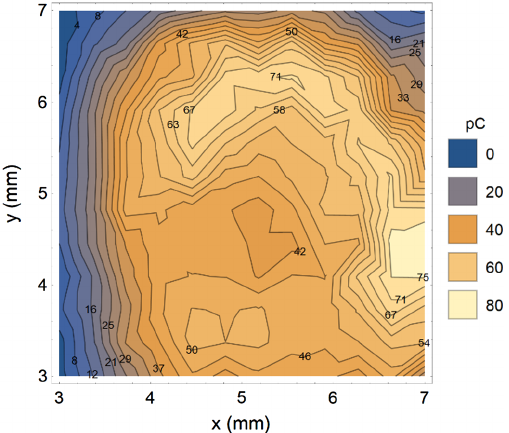
FIG. 31. Electron beam steering on first screen (gray tone) as a function of the laser x , y position (mm) on the virtual cathode. Darker tone indicates smaller steering. The radial laser beam size (shaped by aperture) was 0.25 mm